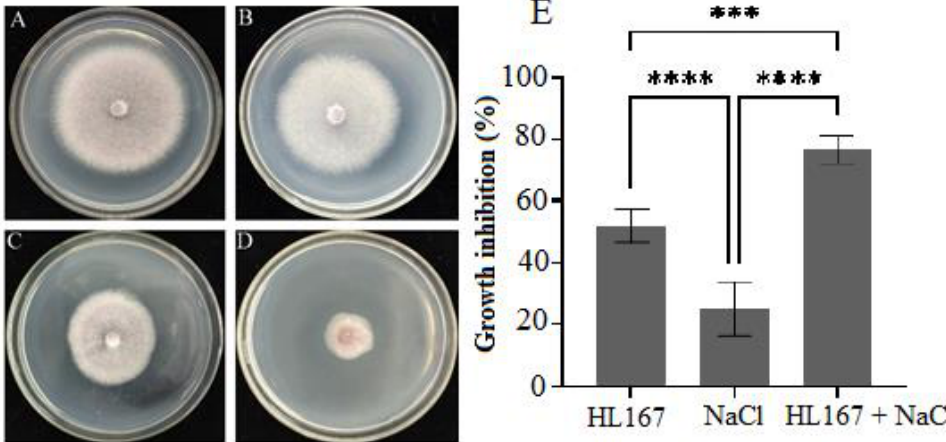
Figure 7. Inhibitory effects of T. longibrachiatum HL167 metabolic produce and 200 mM NaCl on the growth of F. oxysporum . ( A ) Control: Potato dextrose agar (PDA) without T. longibrachiatum HL167 metabolites and 200 mM NaCl. ( B ) PDA with 200 mM NaCl. ( C ) PDA with T. longibrachiatum HL167 metabolites. ( D ) PDA with T. longibrachiatum HL167 metabolites and 200 mM NaCl. ( E ) Growth inhibition (%) of F. oxysporum in different sample treatments, the asterisk “***” indicates p = 0.0002, “****” p < 0.0001 ( n = 3).